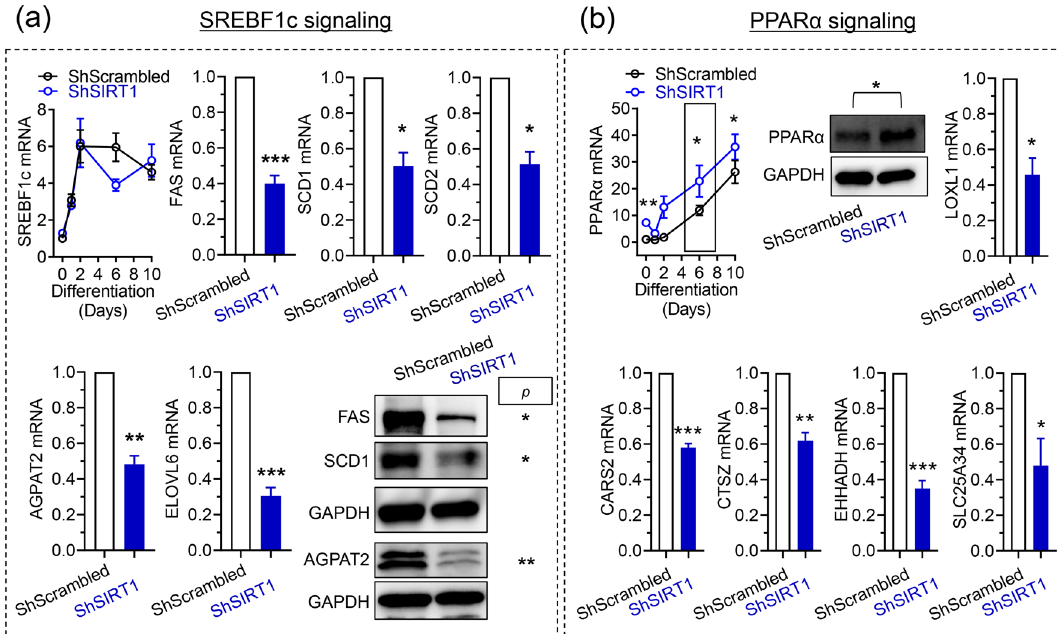
Figure 6. SIRT1-dependence of SREBF1c and PPARα signaling in 3T3-L1 adipocytes. ( a ) Quantitative analysis of the expression levels of SREBF1c and its downstream transcriptional targets in ShScrambled or SIRT1- depleted (ShSIRT1) adipocytes at Day 6 post-differentiation. ( b ) Quantitative analysis of the expression levels of PPARα and its downstream transcriptional targets in ShScrambled or SIRT1-depleted (ShSIRT1) adipocytes at Day 6 post-differentiation. Boxed region indicates the time-point at which PPARα protein levels were quantified. In ( a , b ), qPCR and western blot data were from 4 and 3 independent experiments, respectively. Statistical analysis of the dataset was performed using a Student’s t test (*P < 0.05; ****P < 0.0001; n.s. not is the heat map clustering of the most-significantly affected molecules mapped to their upstream regulators (Red and Blue indicate upregulated and downregulated, respectively). The IPA analysis revealed that the upstream regulators most-significantly affected by SIRT1-depletion were: (a) Peroxisome proliferator-activated receptor-α (PPARα); (b) Sterol regulatory element-binding transcription factor 1/2 (SREBF1/2); (c) peroxisome prolifera- tor-activated receptor gamma coactivator 1-α/β (PGC-1α/β); (d) nuclear factor erythroid 2 Like 2 (NFE2L2); (e) retinoblastoma protein 1 (RB1); and (f) Kruppel-like factor 15 (KLF15). In summary, the data confirmed known regulatory interactions between SIRT1 and transcriptions factors like PGC-1α and uncovered new targets whose function was predicted to be SIRT1-dependent in adipocytes, including SREBF1/2 and PPARα. To independently investigate the positive functional interaction of SIRT1 with SREBF1 and PPARα uncovered by the proteomics analysis, experiments were performed to compare changes in signaling by these transcription factors in ShScrambled and SIRT1-depleted (ShSIRT1) adipocytes. Because bioinformatics analysis predicted that fatty acid biosynthesis was suppressed in SIRT1-depleted adipocytes, experiments were designed to quantify changes in signaling via SREBF1c, which transcriptionally induces enzymes essential for fatty acid synthesis 37 . Analysis of SREBF1c transcript levels indicated that the increase in SREBF1c mRNA during differentiation was largely unaffected by SIRT1-depletion. However, expression levels of its downstream targets were significantly reduced, including fatty acid synthase (FAS), stearoyl-CoA desaturase-1 (SCD1), stearoyl-CoA desaturase-2 (SCD2), 1-Acylglycerol-3-Phosphate O-Acyltransferase-2 (AGPAT2), and elongation of very-long chain fatty acids 6 (ELOVL6) (Fig. 6a, Supplementary Figure S2a). These data also independently validated the proteomics study, which uncovered downregulation of FAS, SCD1, SCD2, and AGPAT2 in SIRT1-depleted adipocytes (Sup- plementary Table S2). Investigations of PPARα revealed that its mRNA and protein levels were significantly higher in SIRT1-depleted adipocytes, prompting us to investigate if its transcriptional function was altered (Fig. 6b, Supplementary Figure S2a). Genes induced by the specific PPARα agonist fenofibrate in brown adipocytes were recently reported 38 . Therefore, expression levels of these targets were compared in ShScrambled and ShSIRT1 adipocytes, revealing that SIRT1-depletion was associated with significantly reduced expression of molecules like lysyl oxidase like-1 (LOXL1), cysteinyl-tRNA synthetase-2 (CARS2), cathepsin Z (CTSZ), solute carrier family 25 member 34 (SLC25A34), and enoyl-CoA hydratase and 3-hydroxyacyl CoA dehydrogenase (EHHADH) (Fig. 6b). Importantly, reduced expression of LOXL1, CARS2, and CTASZ in SIRT1-depleted adipocytes was also uncovered by the proteomics analysis (Supplementary Table S2). Collectively, these data suggested SIRT1- dependence of SREBF1c and PPARα signaling in 3T3-L1 adipocytes. CEBPα/β/δ and PPARγ transcription factors also play key roles in 3T3-L1 adipogenesis. Therefore, expression levels of these transcription factors were quantified in ShScrambled and SIRT1-depleted (ShSIRT1) adipocytes to gain insights into their SIRT1-dependence. In ShScrambled adipocytes, CEBPα expression was maximal at Day 6 post-differentiation and SIRT1-depleted adipocytes showed a small but significant reduction (Supplementary Figure S2b). The increase in CEBPβ expression in ShScrambled adipocytes was relatively transient—mRNA levels